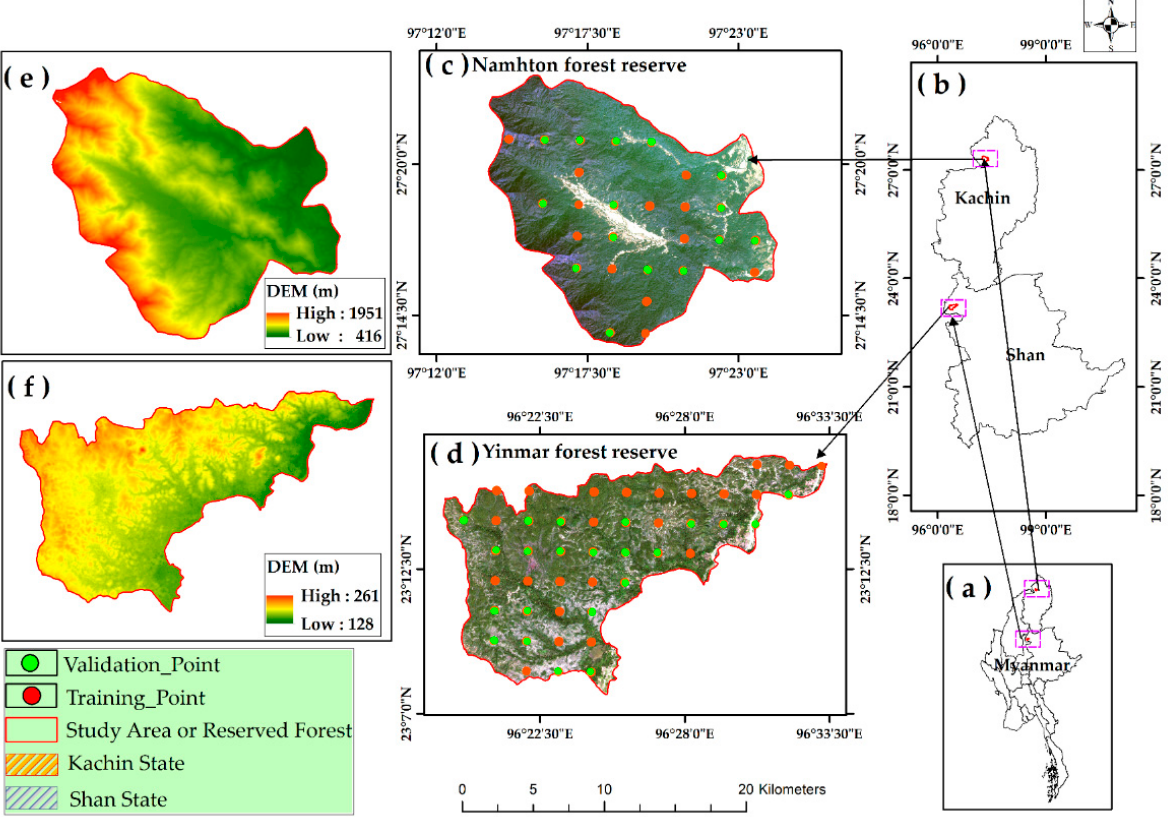
Figure 1. Location of the study area: ( a ) country boundary; ( b ) location of the two forest reserves; ( c ) the Sentinel-2 true color image (collected in 26 January 2017) attached with field sample plots in NH; ( d ) the Sentinel-2 true color image (collected in 5 February 2017) attached with field sample plots in YM; ( e ) the DEM of NH; and ( f ) the DEM of YM .